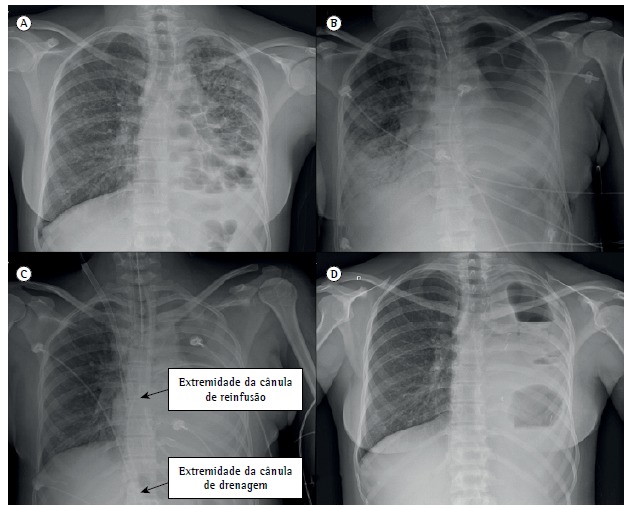
Exames radiológicos que ilustram a evolução da paciente. Em A,
radiografia de tórax no pré-operatório de pneumonectomia, com extensas
bronquiectasias, redução de volume pulmonar e espessamento pleural à
esquerda. Em B, radiografia no 3º dia de pós-operatório, com extensas
consolidações à direita e cavidade pleural de pneumonectomia à esquerda. Em
C, radiografia no dia do desmame da oxigenação extracorpórea por membrana,
no 8º dia de pós-operatório, demonstrando regressão das consolidações à
direita. Observam-se as cânulas venosas com as respectivas extremidades no
átrio direito (linha de reinfusão) e na veia cava inferior na porção
intra-hepática (linha de drenagem). Em D, radiografia retirada três meses
após a alta hospitalar, demonstrando a cavidade de pneumonectomia à esquerda
quase totalmente obliterada.